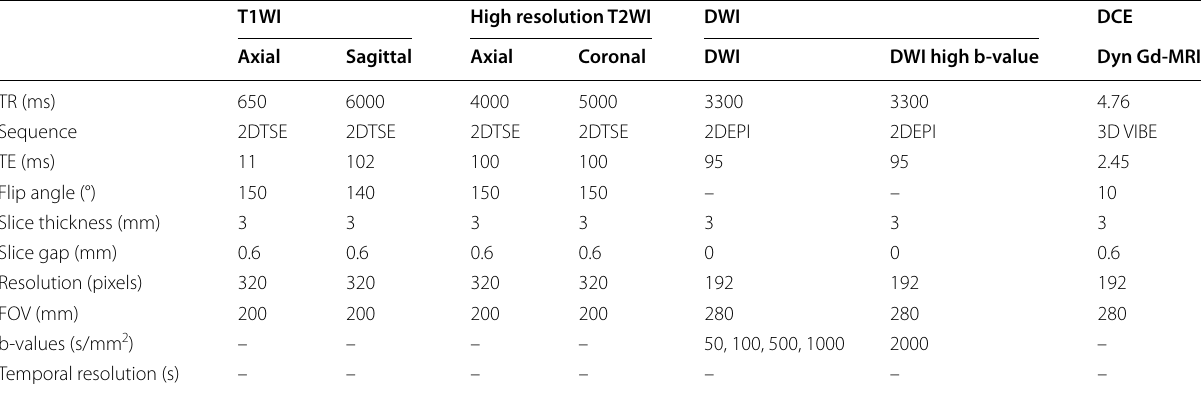
Table 2 MRI acquisition